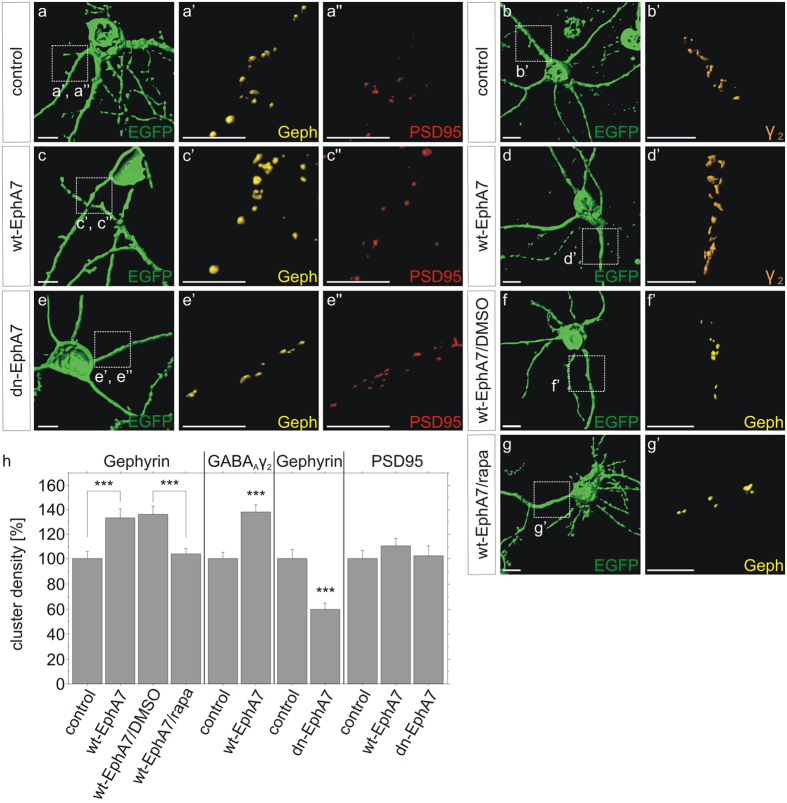
Overexpression of wild type EphA7 or stimulation with ephrin A5 increases while protein kinase-deficient EphA7 reduces gephyrin clustering.(a,c,e) After cotransfection of pEGFP-N1 and wildtype EphA7 (wt-EphA7) or dominant-negativ EphA7 (dn-EphA7), cells were stained for gephyrin (yellow, a’,c’, e’) or PSD95 (red, a”,c”, e”). Magnifications of insets in (a-g) are shown in (a’–g’), and in (a”–e”), respectively. All images were rendered using Imaris software. Scale bars, 10 μm. (b,d) control and wt-EphA7 transfected cells were stained for the γ2 subunit of GABAA receptors. (f,g) Neurons transfected with wt-EphA7 were treated with DMSO or rapamycin/DMSO (rapa) and subsequently stained for gephyrin. (h) The densities of gephyrin, γ2 subunit of GABAA receptors and PSD95 punctae were quantified in transfected neurons as identified by EGFP fluorescence. wt-EphA7: gephyrin, n = 50; GABAA γ2, n = 45; PSD95, n = 30. dn-EphA7: gephyrin, n = 30, ***p < 0.0001, ANOVA, Fisher-PLSD. Error bars, S.E.M.